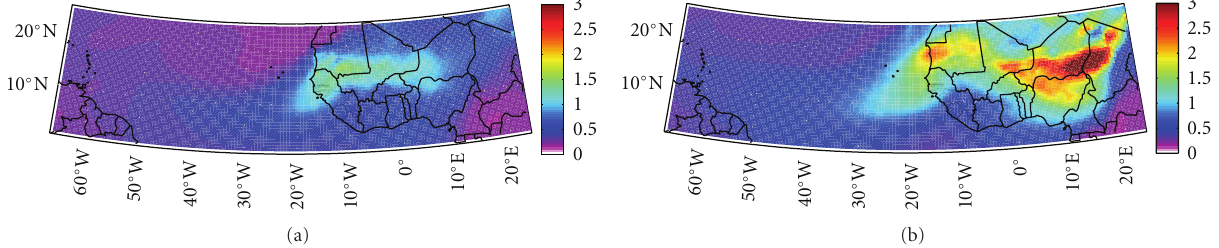
Figure 2: Mean AOD values during dust episodes simulated with the RegCM 4.0: (a) March 5–8 and (b) March 17–21.